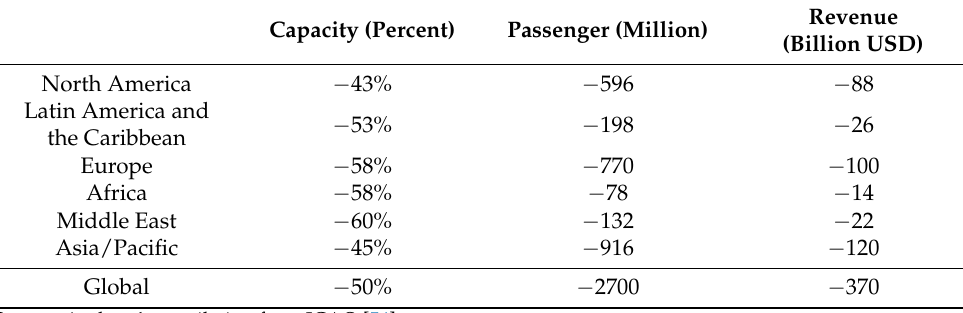
Table 2. Change in passenger traffic and revenues by region, 2019–2020. Capacity (Percent) Passenger